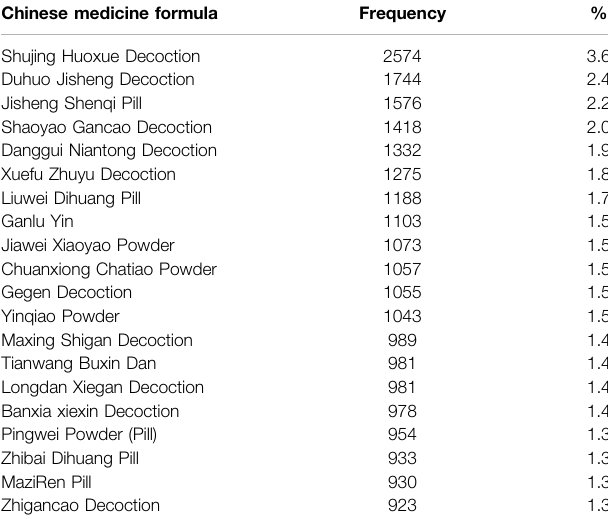
TABLE 5 | The top 20 used Chinese medicine formulas. Chinese medicine formula